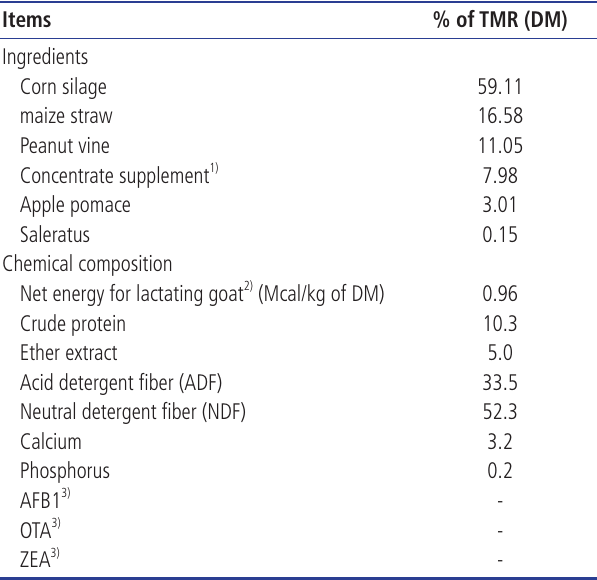
Table 1. Ingredients and chemical composition of the total mix ration (TMR) fed to dairy goat during the